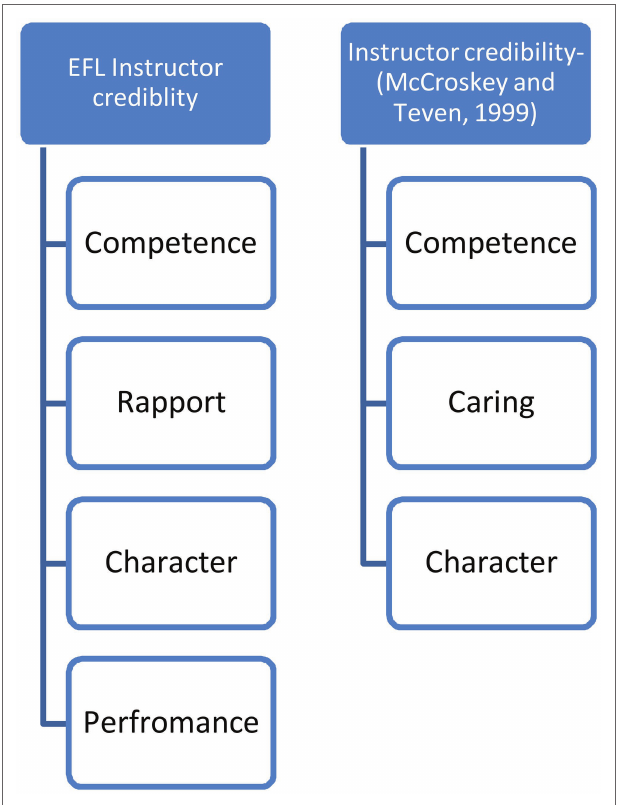
FIGURE 1 | Instructor credibility